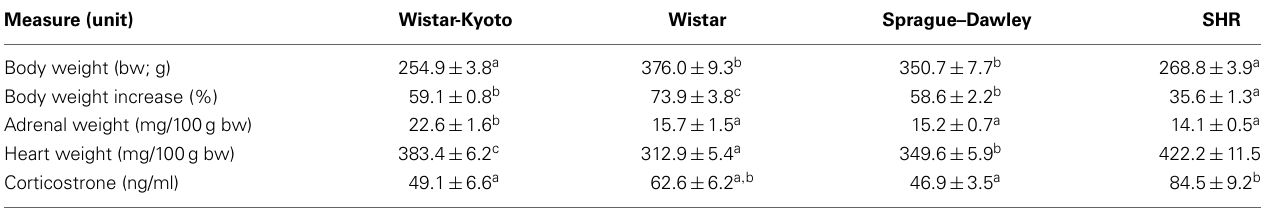
Table 1 | Body and organ weights and corticosterone